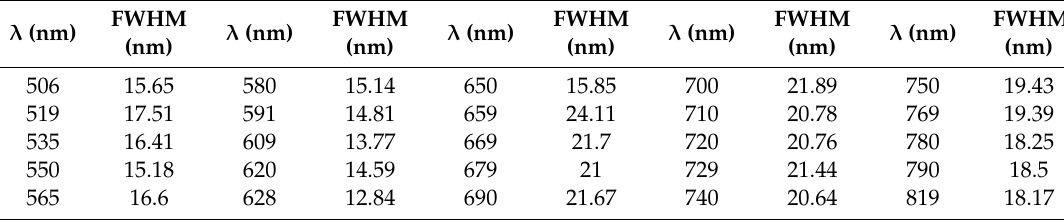
Table 2. Spectral settings for the hyperspectral camera selected for this study ( λ = central wavelength of the spectral band).